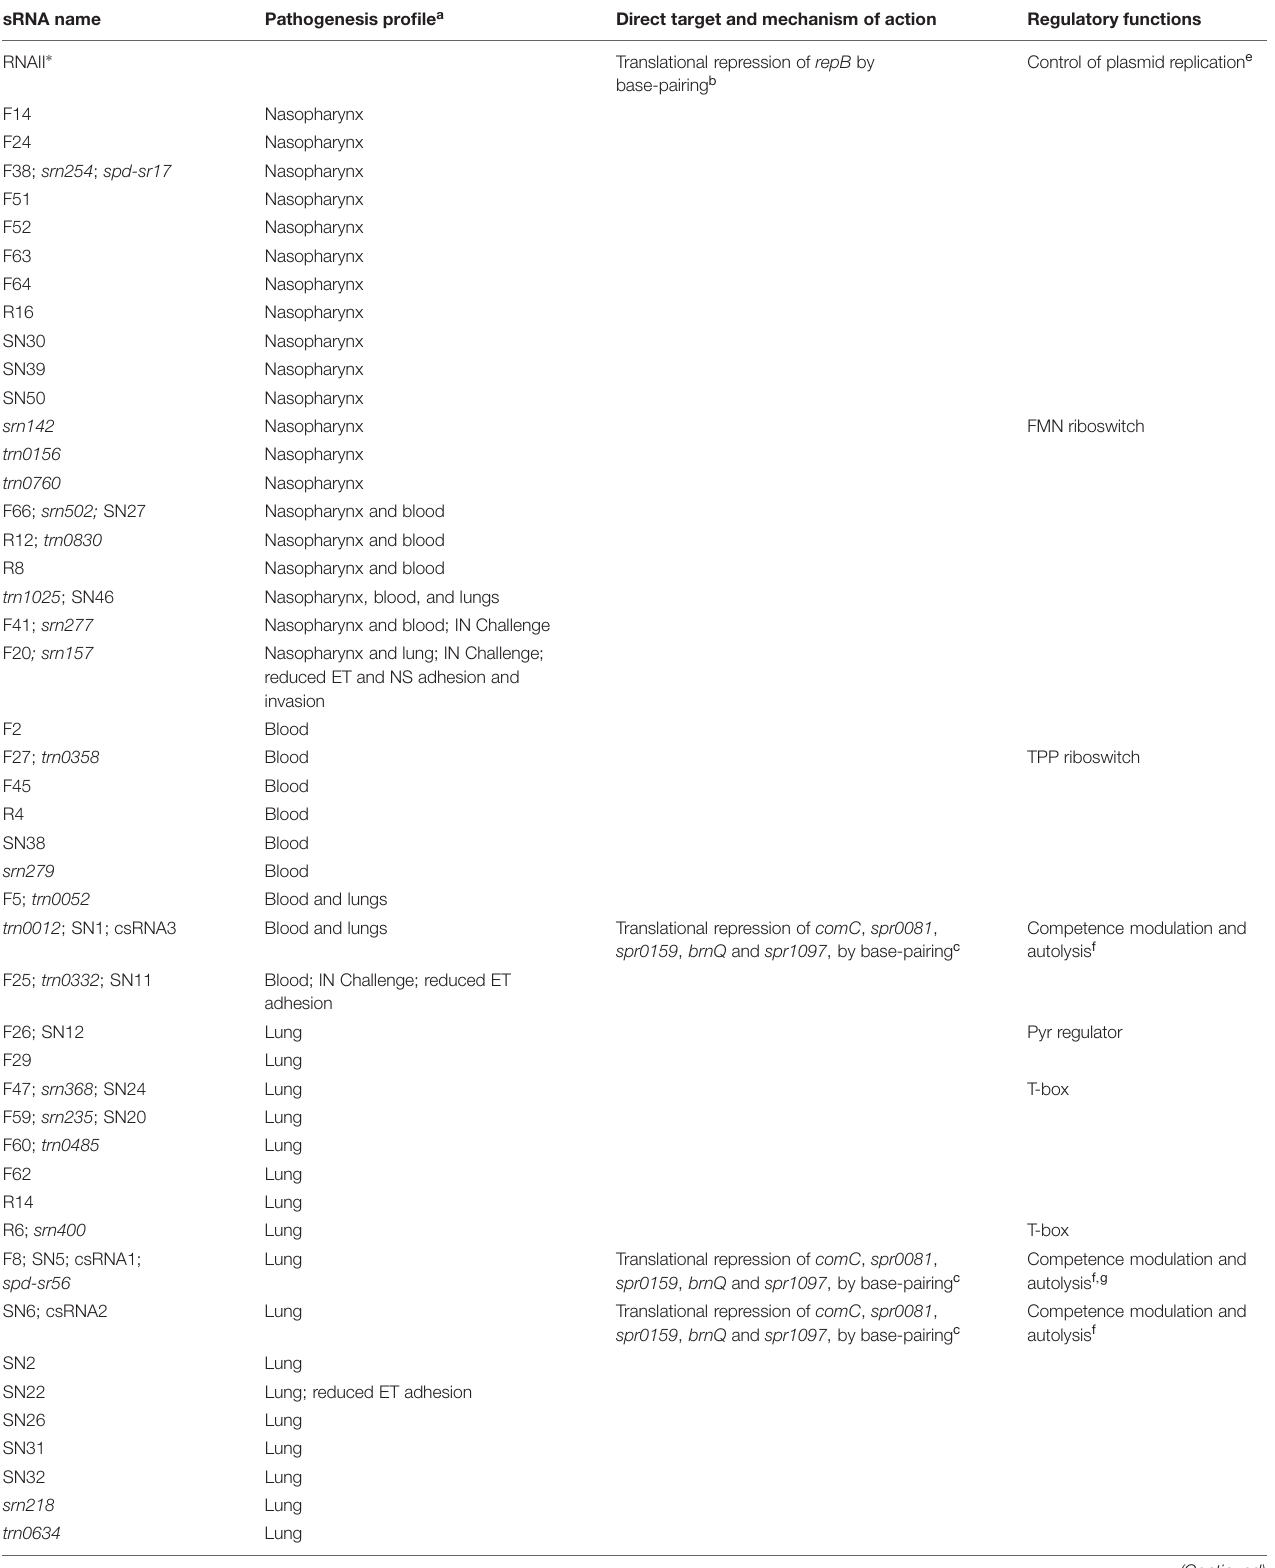
TABLE 1 | Studied small RNAs (sRNAs) in pneumococci.